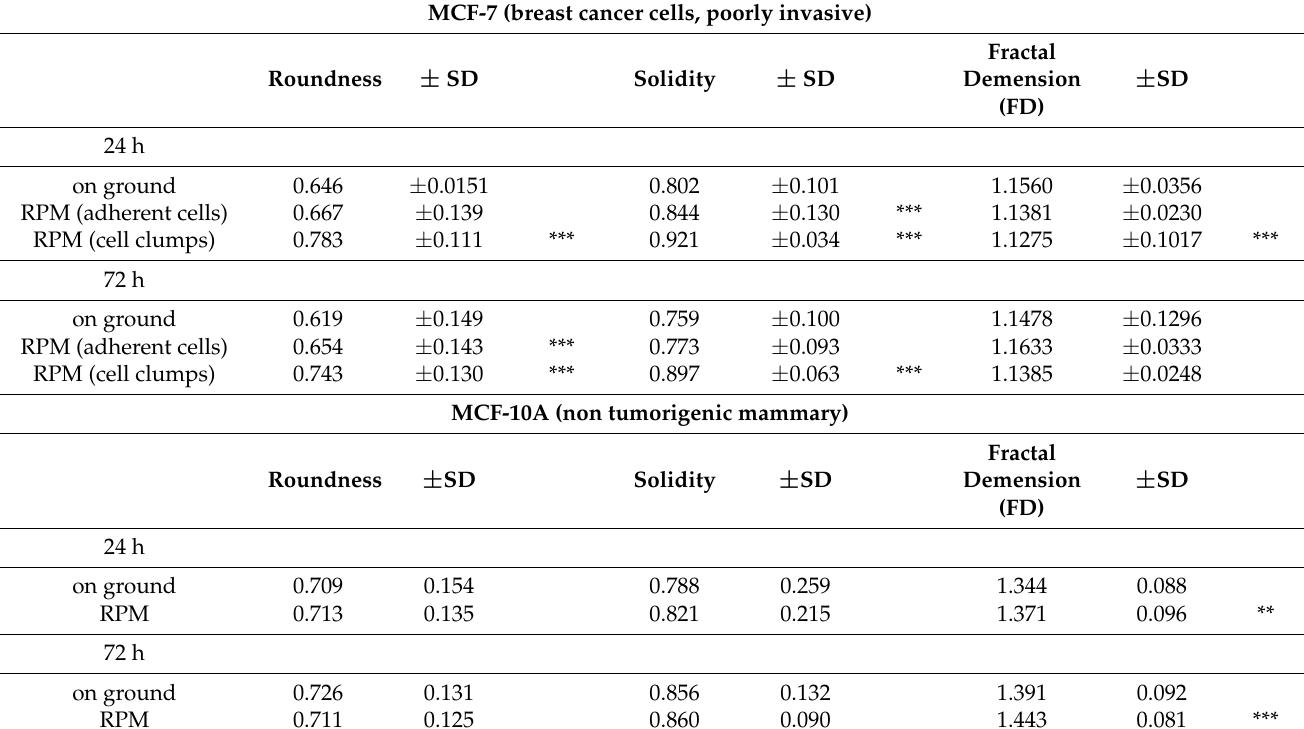
Table 1. Roundness, solidity, and fractal dimension (FD) in MCF-7 and MCF-10A at 24 h and 72 h. Mean values ± SD in on-ground control cells, RPM adherent cells, and RPM cell clumps. ** p < 0.01 versus on-ground control cells; *** p < 0.001 vs. on-ground control and RPM adherent cells by ANOVA followed by Bonferroni post-test. (Sample size = 50 cells for each